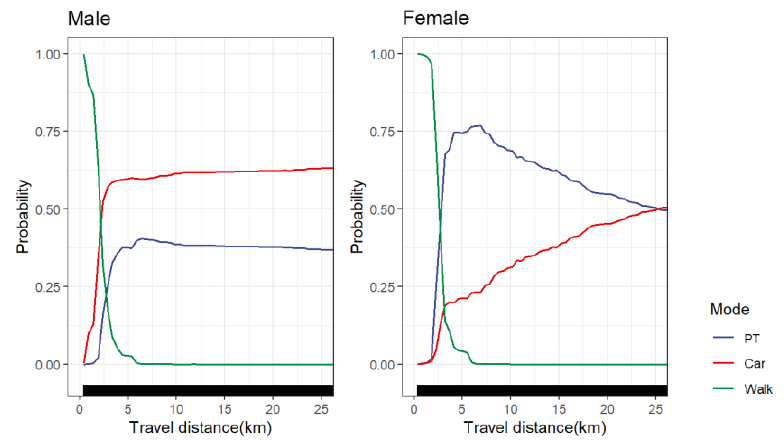
Figure 8. PDP plot of gender groups differences.